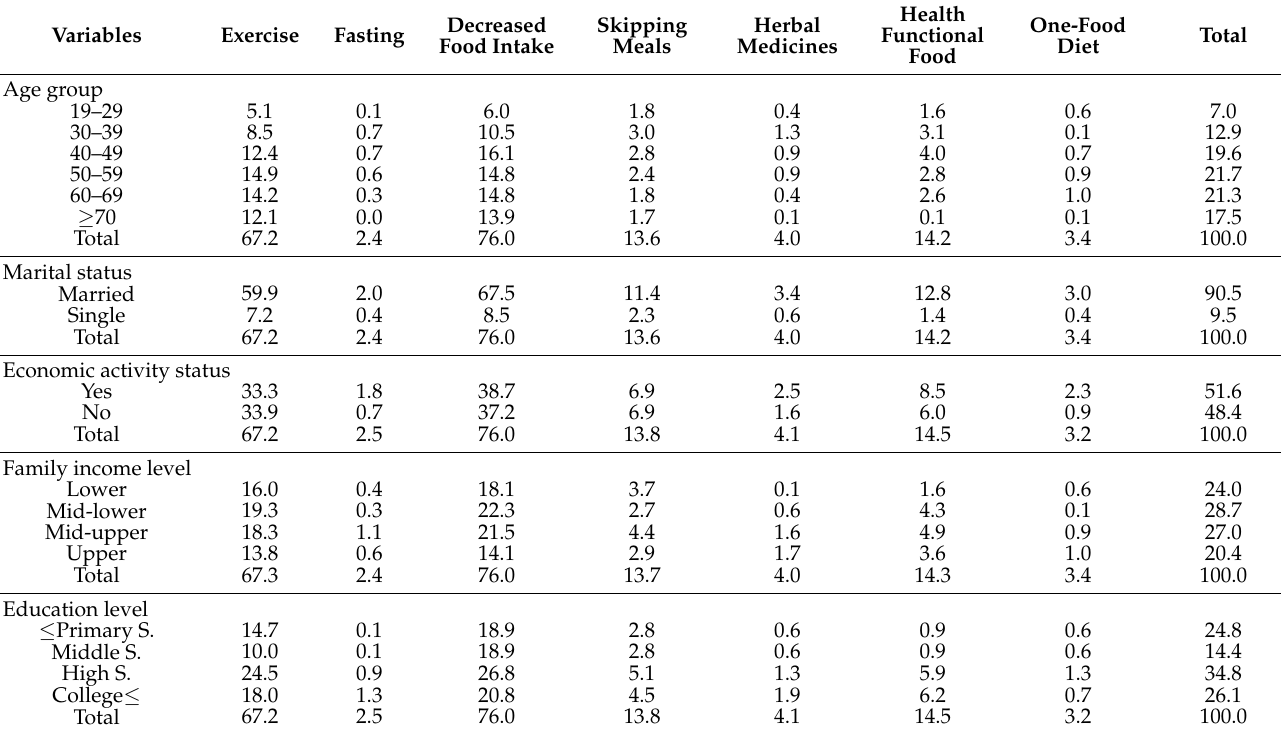
Table 5. CIHA for weight management according to general characteristics in Korean obese women population ( ≥ 19 years old). Variables